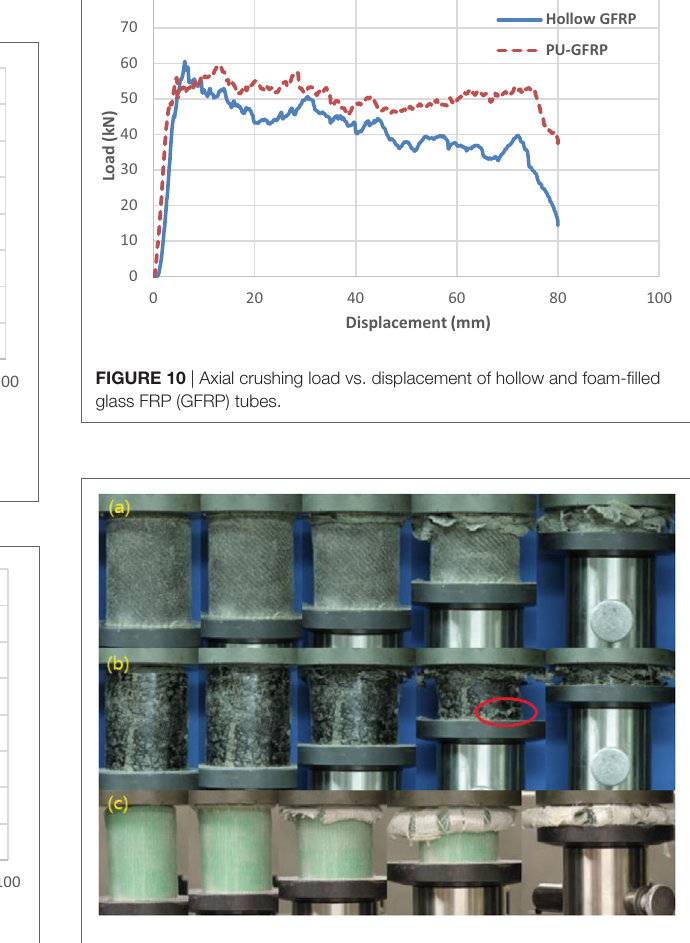
FigUre 11 | Typical progressive crushing processes of foam-filled fiber reinforced polymer tubes: (a) flax, (B) basalt, and (c)